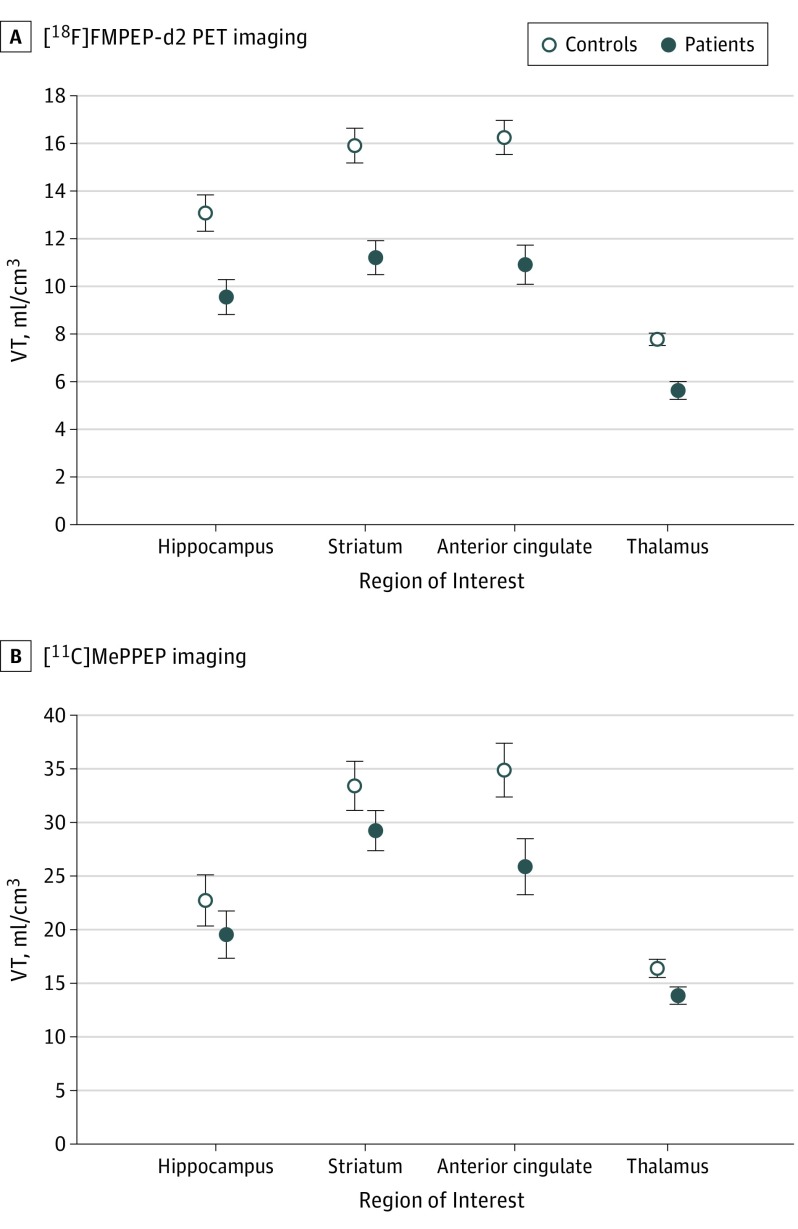
Cannabinoid 1 Receptor Availability Across Regions of Interest Cannabinoid 1 receptor availability measured by positron emission tomographic (PET) imaging was significantly lower in each region of interest in patients taking antipsychotic medication with first-episode psychosis relative to matched controls (panel A) and untreated patients with first-episode psychosis relative to matched controls (panel B). Data are expressed as mean (SD) of the distribution volume (VT) of fluoride 18–labeled FMPEP-d2 and carbon 11–labeled MePPEP radiotracers.